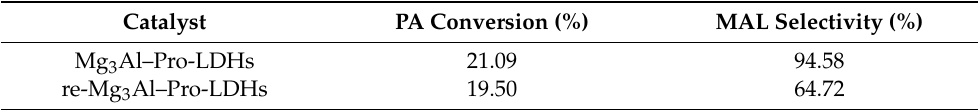
Table 3. Results of the aldol condensation using LDHs with L-proline intercalation.